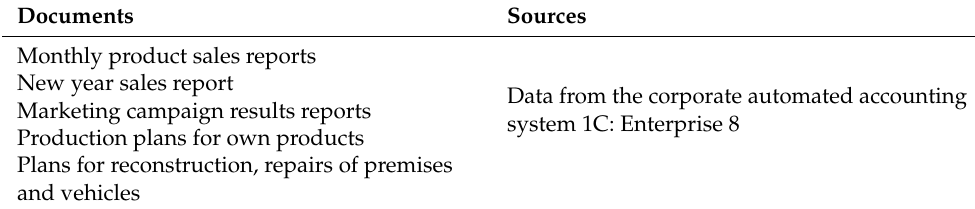
Table 1. Sources of raw data for